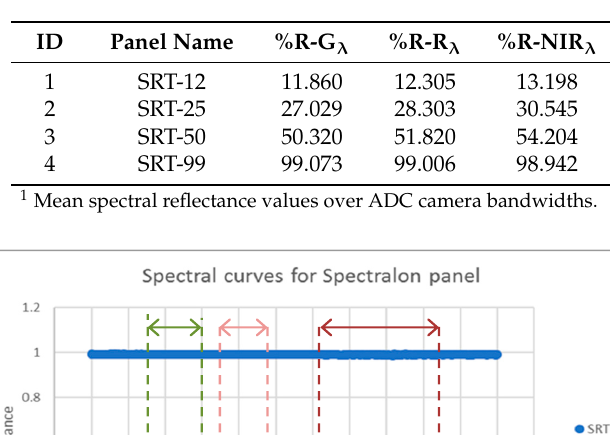
Figure 3. Dulux colour cards ( a ) and Spectralon multi-step calibration target (striped) ( b ).